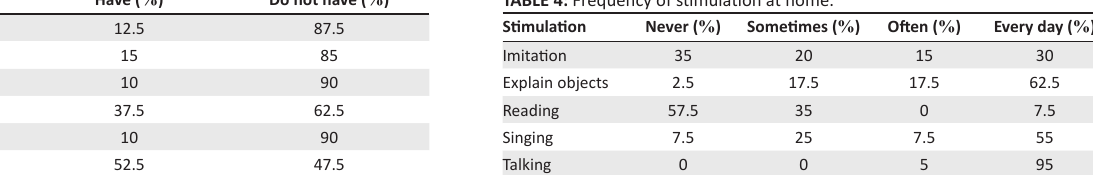
TABLE 3: Educational toys at home for all children. Educational